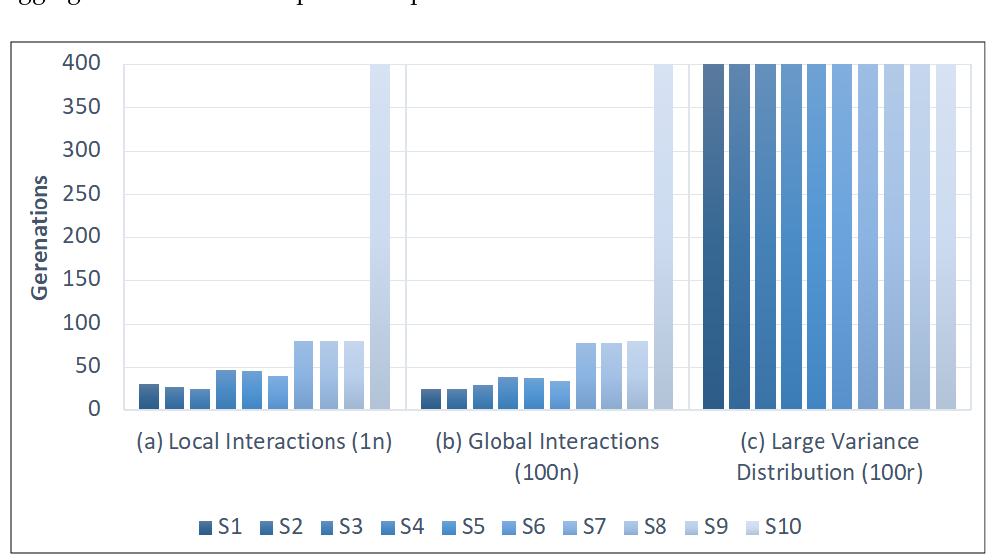
Figure 5. Local vs. global interactions. Data obtained from 1Plank4.json in Supplementary Material: 10 species ( S1 to S10 ) compete on equal terms, with only variations in the descendants ( S1 – S3 have 3 DirectOffspring , S4 – S6 have 4, S7 – S9 have 5, and S10 have 6 DirectOffspring ). We use a different dispersion strategy in each figure. Each blue bar on the X -axis represents the surviving generations of each of the 10 species until each becomes extinct by competitive exclusion. We observe that the more competitive species remain longer when they interact locally under the strategy 1n ( b ) than when they use the strategy 100n ( a ). This difference is more significant with aggregated distribution, which has a greater variance, such as 100r ( c ): no species is excluded in 400 generations.